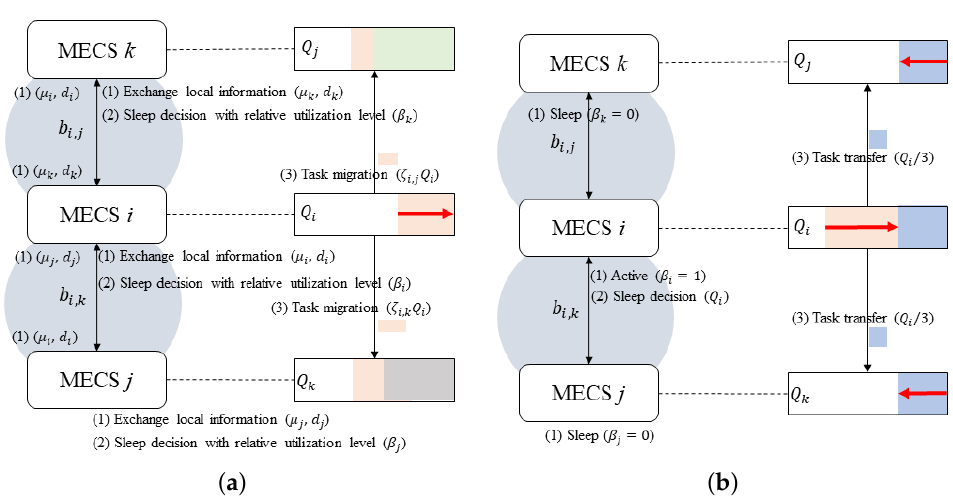
Figure 1. An overview of the sleep control mechanism. ( a ) Sleep example; ( b ) Wake-up